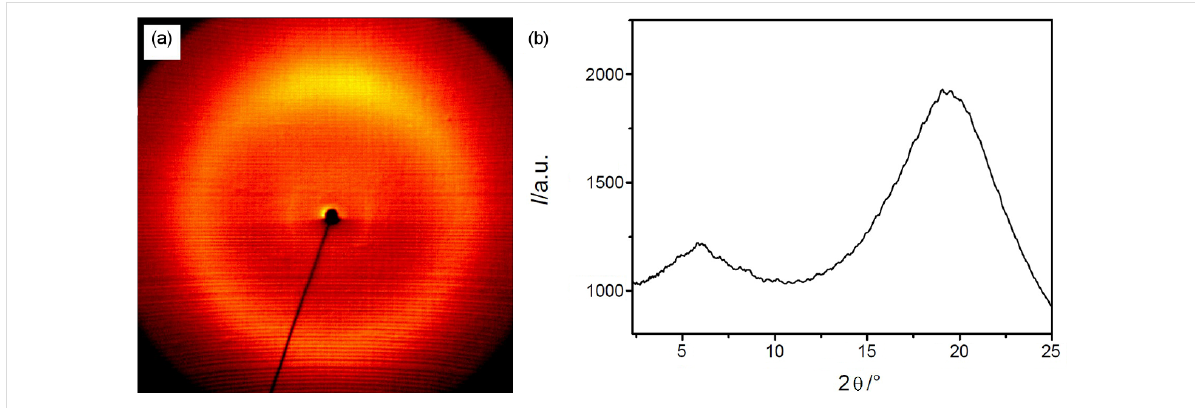
Figure 1: XRD pattern of a (partially) surface-aligned sample of the N phase of compound CB-Ox-CB/4 : (a) diffraction pattern at 170 °C; (b) θ -scan at 170 °C.